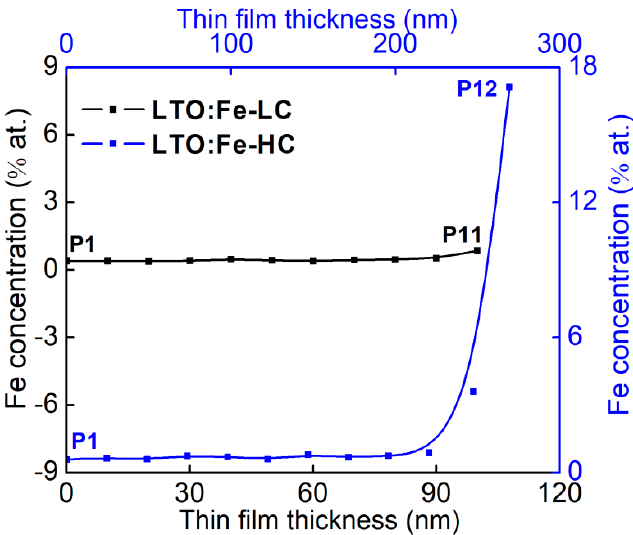
Figure 5. Variation in the Fe concentration through the cross-section of the thin films.